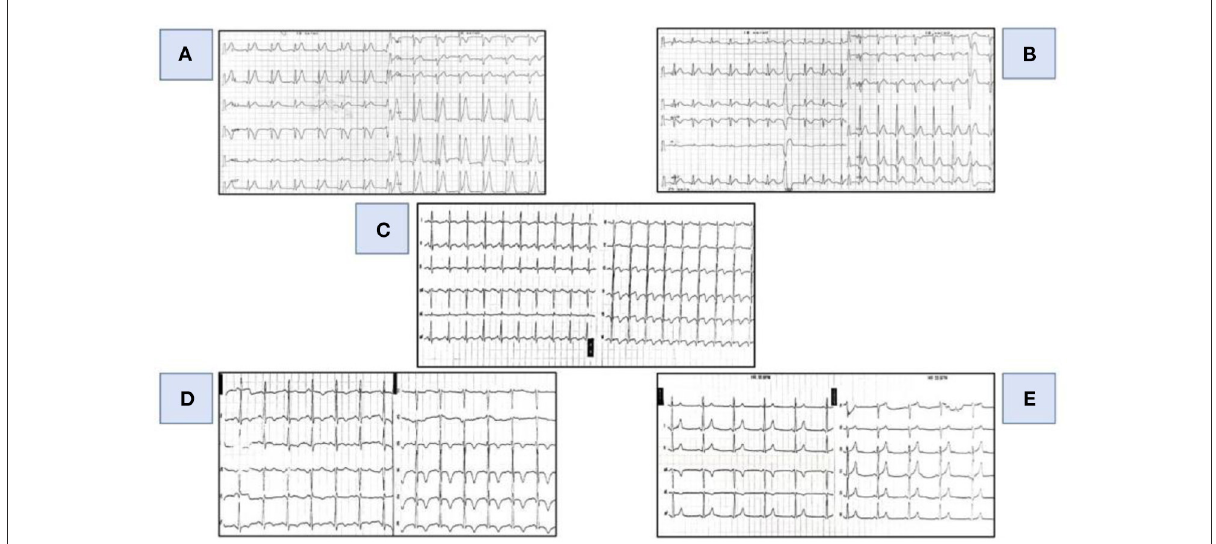
FIGURE1 Evolutionary changes in the ECG. (A) (First day-07.14 AM: ECG at initial presentation): tall, spiky T waves diffusely in the ECG. (B) (First day-07.57 PM): concave ST elevation in the inferior and lateral series of leads. (C) (First day- 22.09 PM): ST elevation in the inferior and lateral series of leads with terminally negative T waves. (D) (Second day- 06.50 AM) : negative T waves in the inferior and lateral series of leads. (E) (Fifth day- 07.00 AM): normal